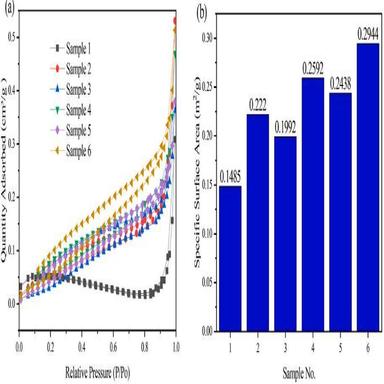
Isothermal N2 adsorption/desorption curves (a) and specific surface area (b) of BS and composite PCMs.